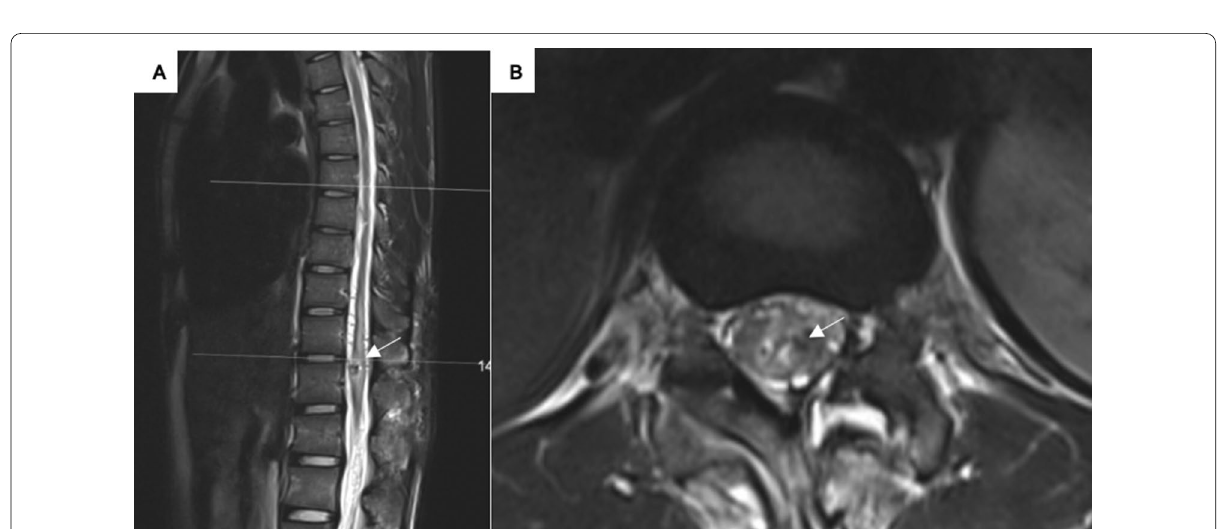
Fig. 3 Postoperative MRI ( A ) Sagittal T1 and ( B ) axial T1-weighted gadolinium-enhanced showing a small residual tumour (white